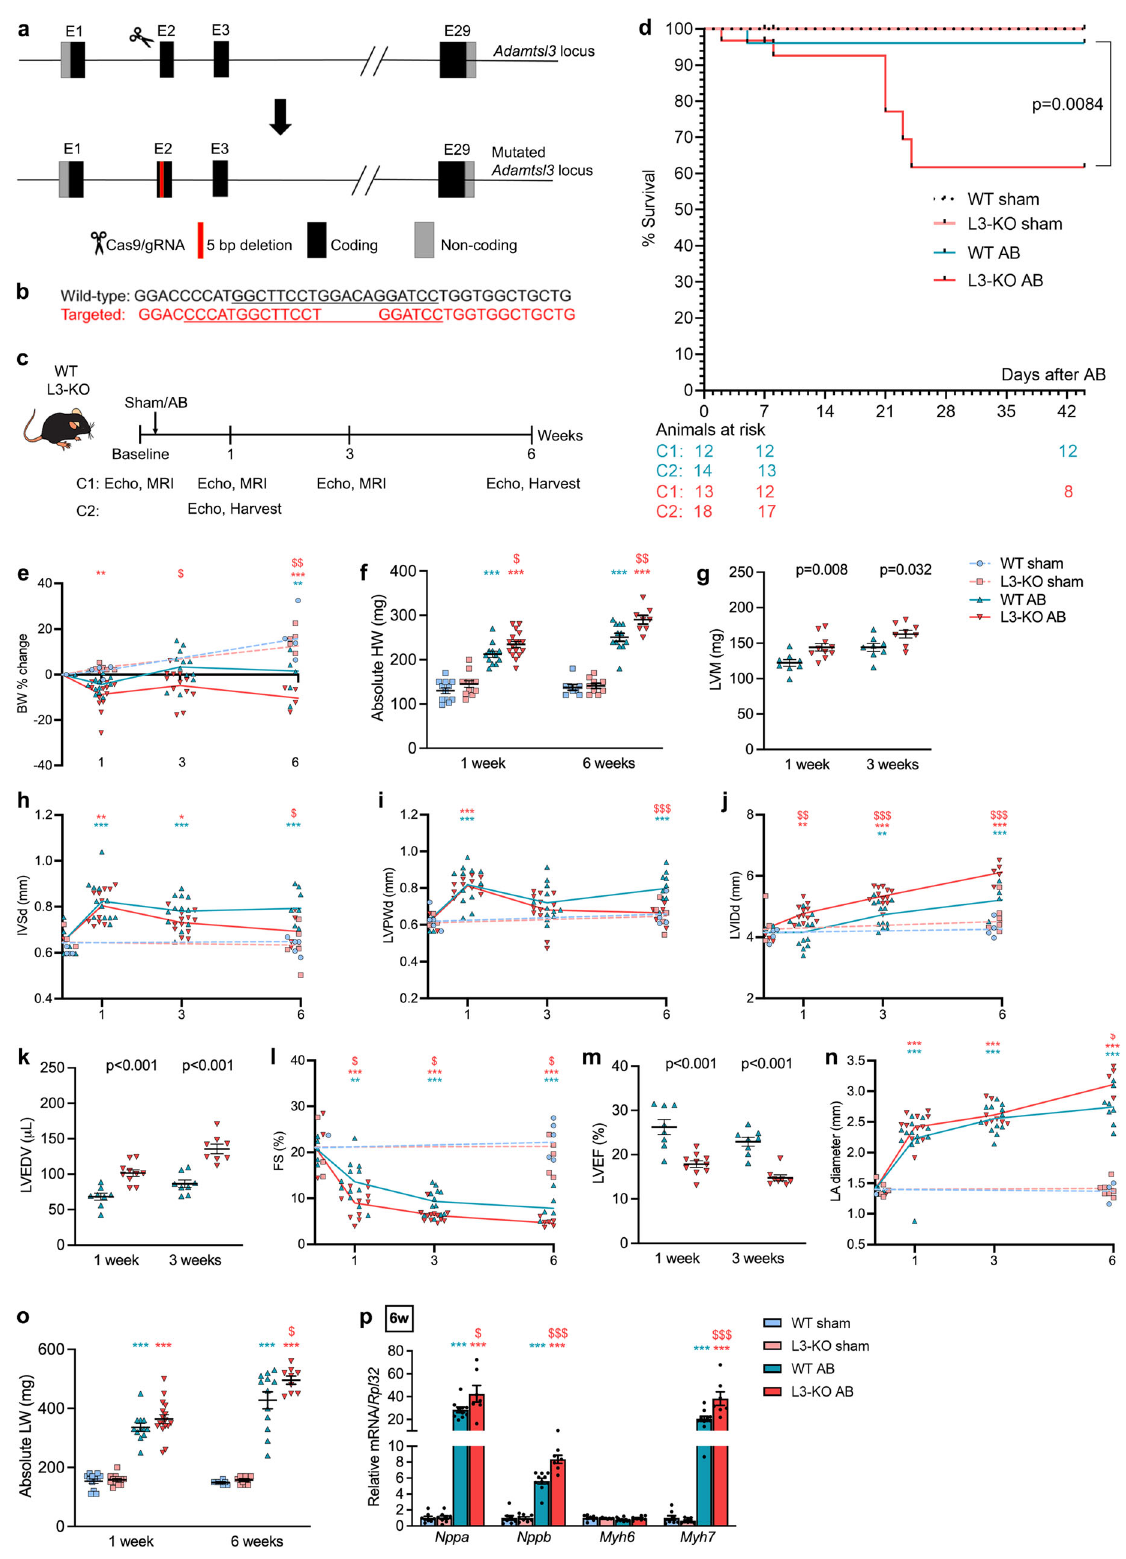
expression was increased in L3-KO vs. WT LVs at six weeks (Fig. 2p), consistent with ongoing cardiomyocyte remodelling and dysfunction 23 . Altogether, these data demonstrate that L3-KOs developed exacerbated cardiac dilatation and contractile dysfunc- tion with faster progression to decompensation vs. WTs, upon equally imposed LV